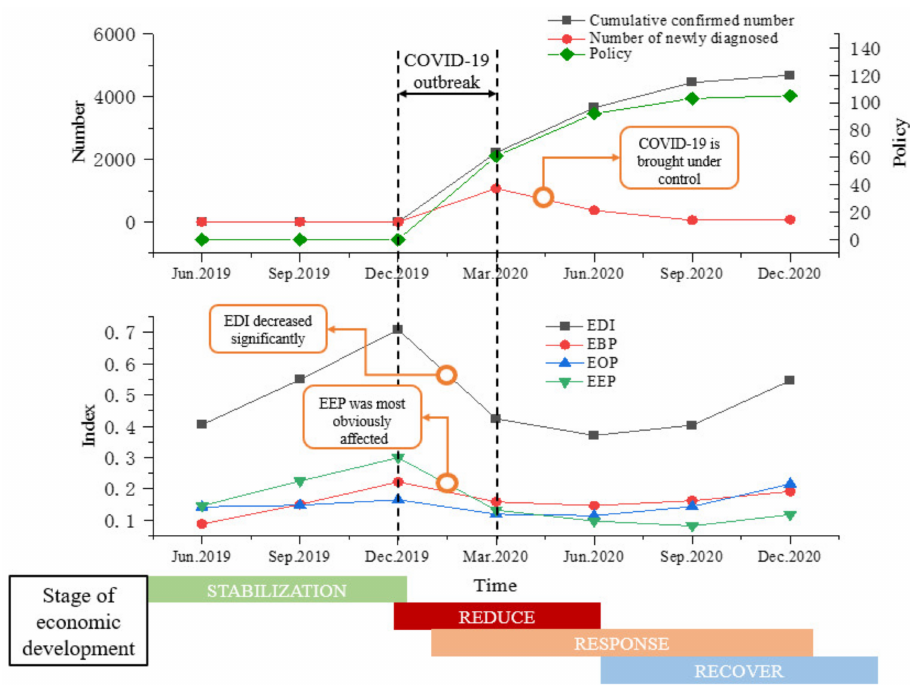
Figure 6. The EDI of the Beijing–Tianjin–Hebei urban agglomeration, the trend of confirmed number and industrial policy before and after the